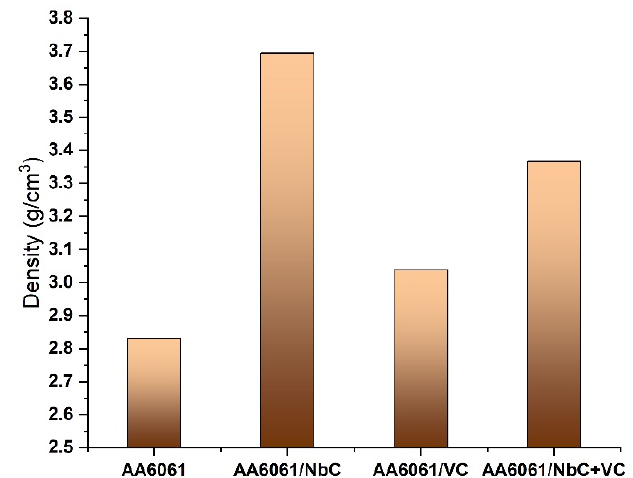
Figure 7. The bulk density of the samples.